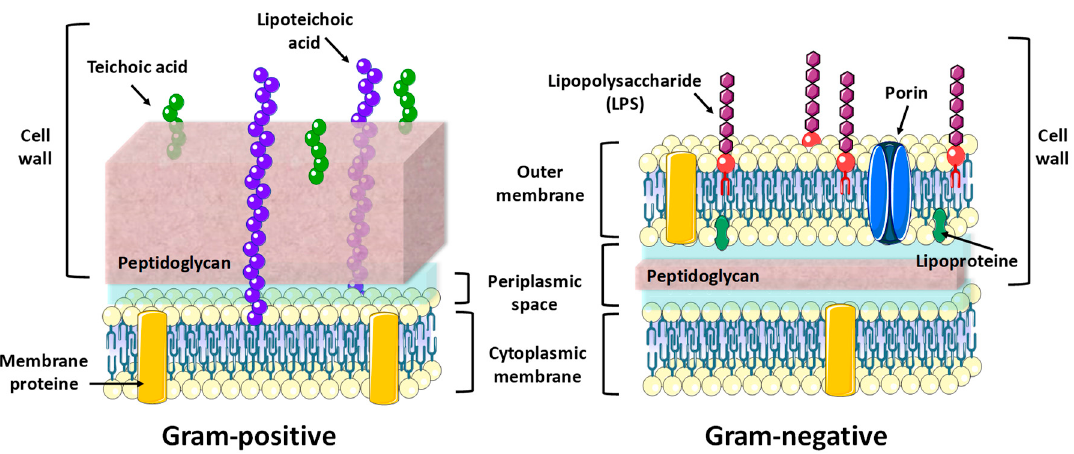
Figure 4. Comparison between structures and cell wall components of G + and G − bacteria. Build upon the material available in the website https://smart.servier.com.